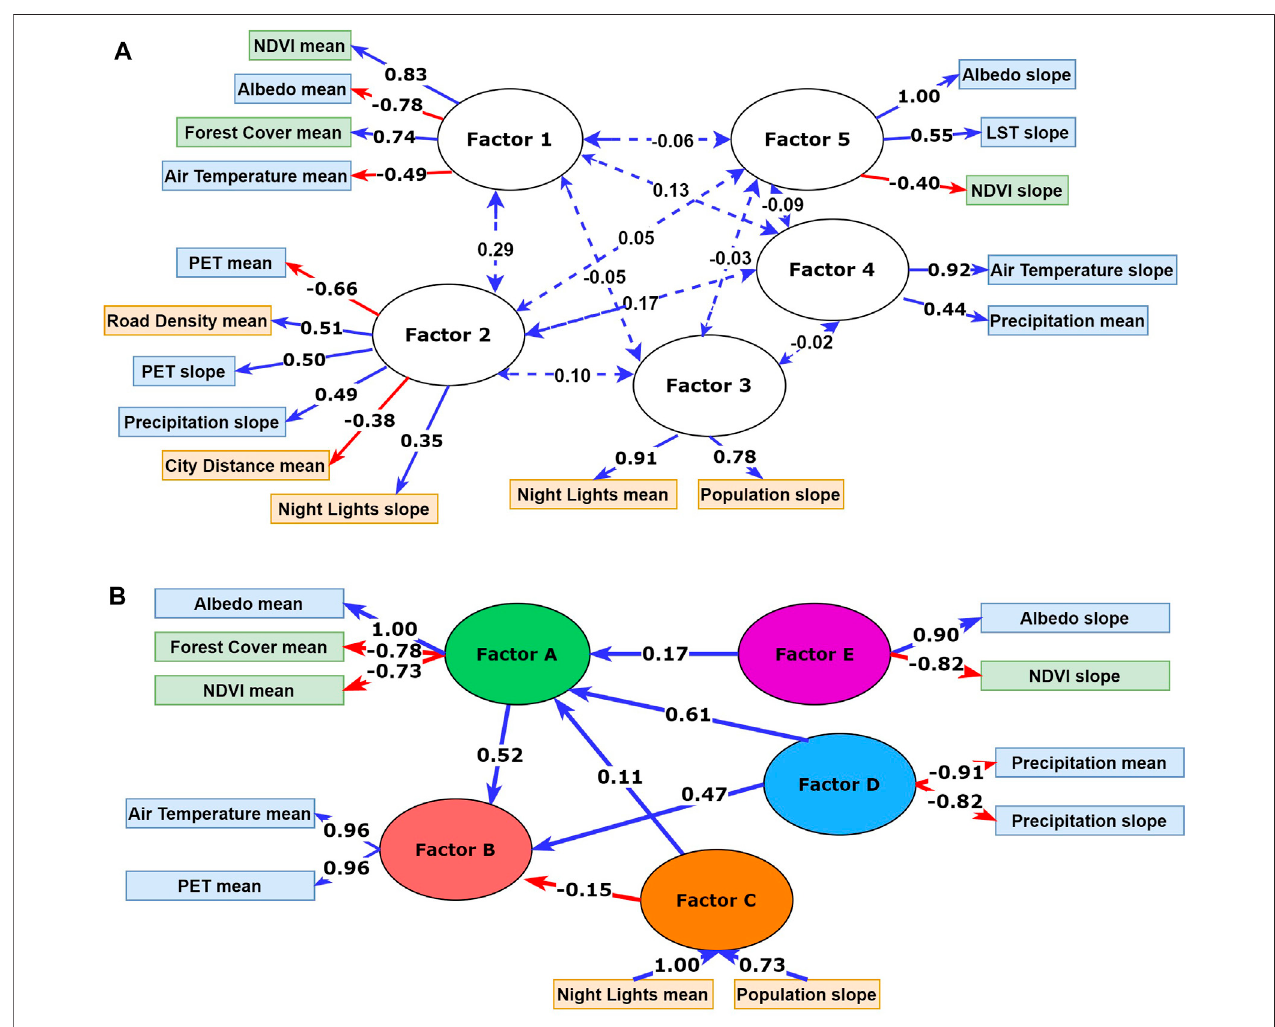
FIGURE7|(A) PreliminaryformofthemodelsuggestedbytheEFA.Solidarrowsrepresentblockcorrelationsoffactorswithrespectivemanifestvariables,dashed arrows represent covariancesbetweenlatentvectors. Manifestvariablesarecolorcodedasvegetation(green), climatic (blue),and anthropogenic(yellow). (B) Finalform of the PLS path model formulated for explaining the relationships between environmental, demographic, and spatial factors in fl uencing LC change in Ghana.